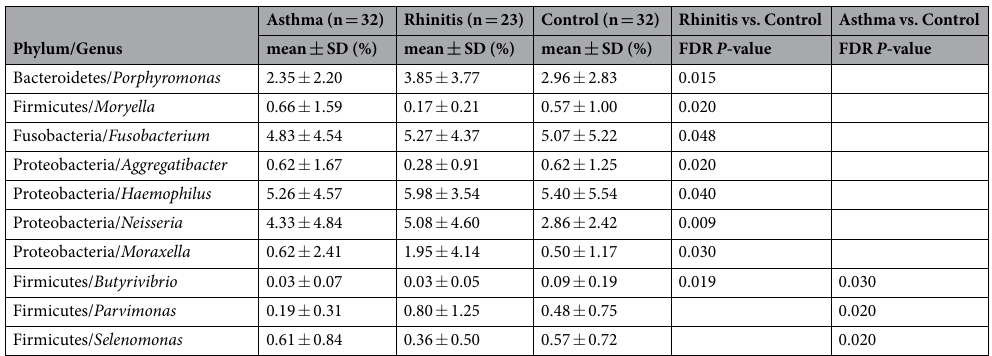
Table 2. Differences and comparisons of bacteria in phyla and genera among children with asthma, rhinitis and healthy controls. Data shown are mean ± SD of relative abundance of bacteria. The percent of total numbers of sequences are shown for each split level. Only taxonomic classification with more than 100 sequences or 0.01% of total sequences, and statistically significant differences are shown. FDR-adjusted P -values are calculated by metagenomeSeq differential abundance tests in the R software using subsampled microbial